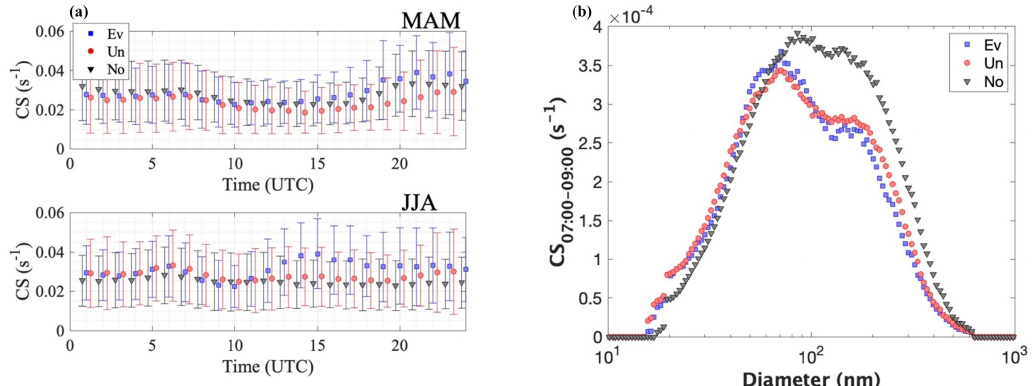
Figure 8. (a) Diel variations of the condensation sink (CS) during spring (MAM) and summer (JJA) seasons, and (b) median size-resolved background CS (from 07:00 to 09:00UTC) for MAM and JJA during event days (Ev, blue squares), undefined (Un, red dots), and non-event days (No, black